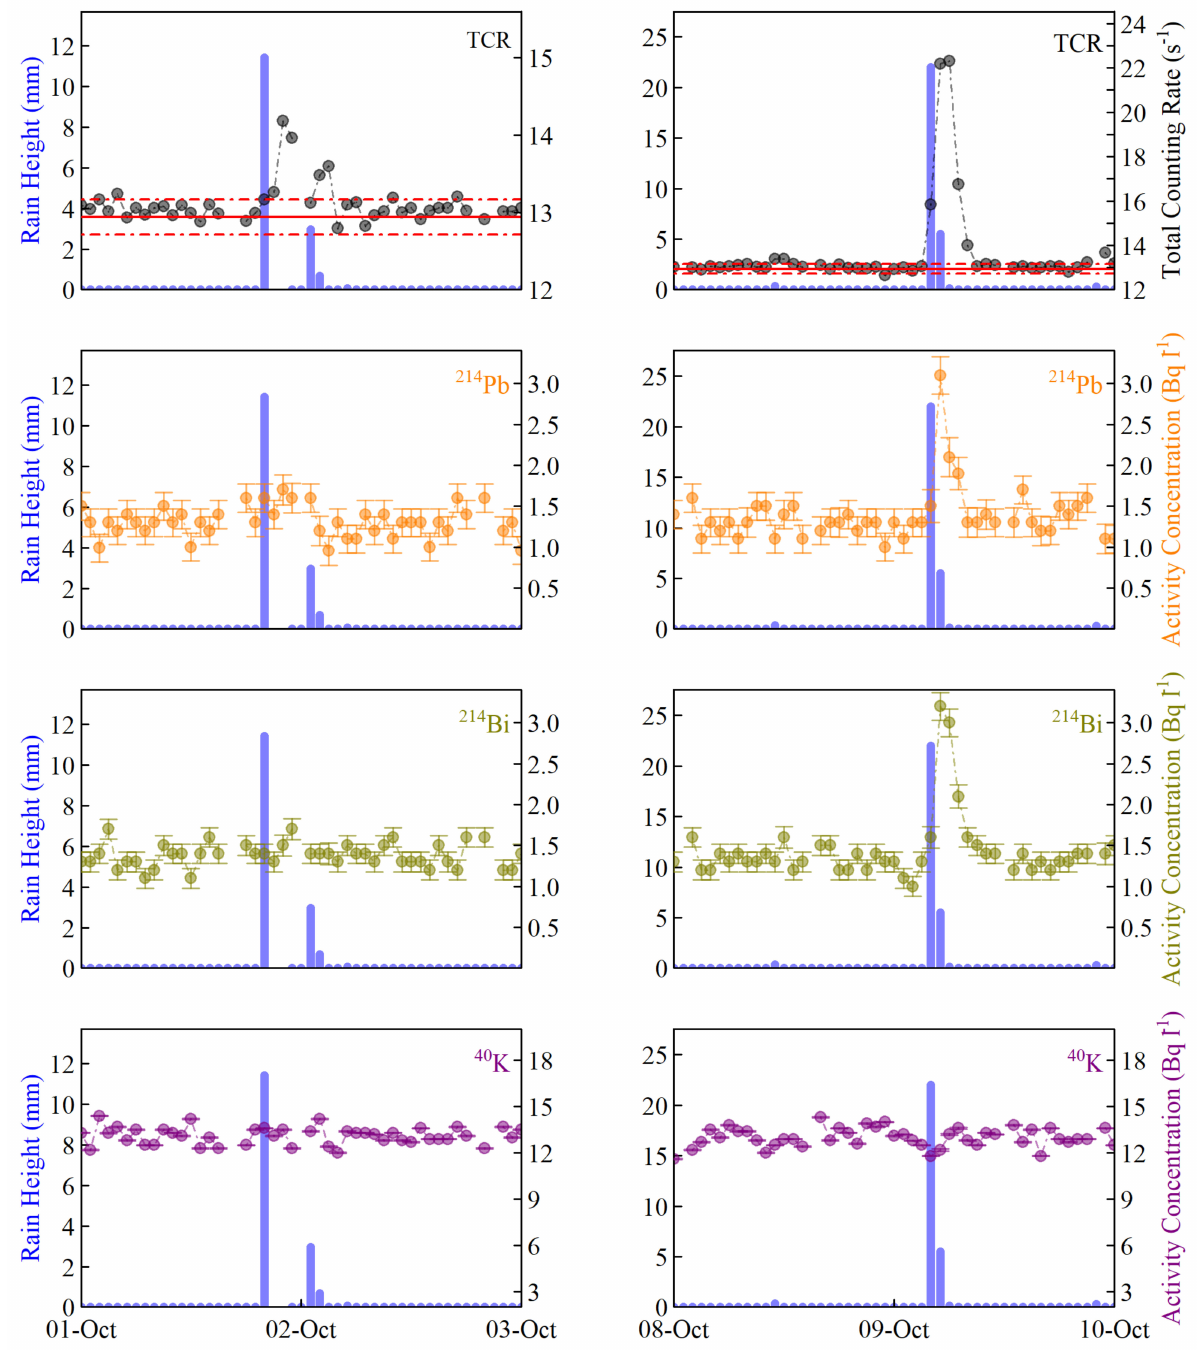
Figure A5. Representative rainfall events of October 2016. The y -axis of the first column regards rain height values (blue bars) while of the second TCR values, 214 Pb, 214 Bi and 40 K activity concentration (circular points). In the subplots of TCR, the mean value during dry meteorological periods is depicted as a red solid line, and the range of the statistically significant criterion is depicted with red dotted